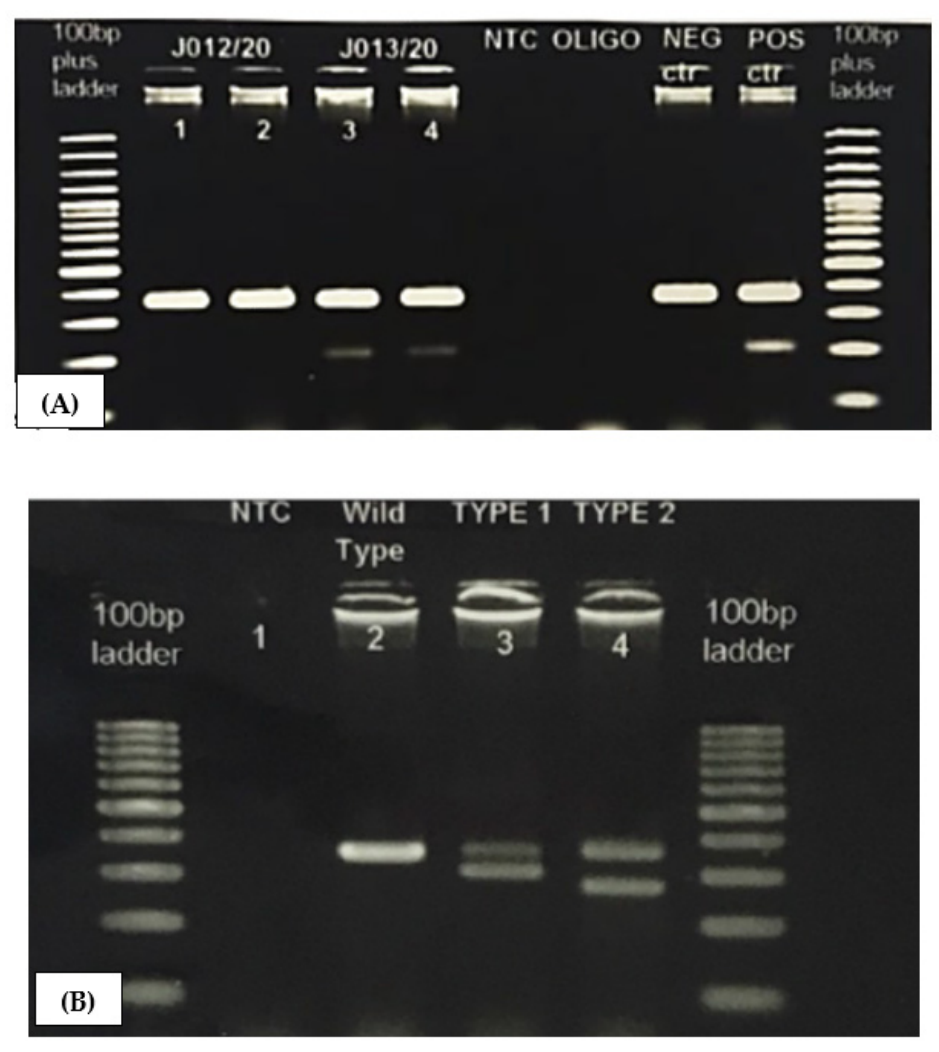
Figure 2. PCR products with gel electrophoresis. Electrophoresis of amplified PCR products to detect ( A ) JAK2 V617F mutations: Lanes 1–2 are normal cases with only wild-type at 364 bp, Lanes 3–4 are positive for the JAK2 V617F mutation, with wild-type at 364 bp and a mutant band at 203 bp; ( B ) CALR mutations: Lane 2 is a normal case with only wild-type at 357 bp, Lane 3 is positive for CALR Type 1 (302 bp), and Lane 4 is positive for CALR Type 2 (272 bp).